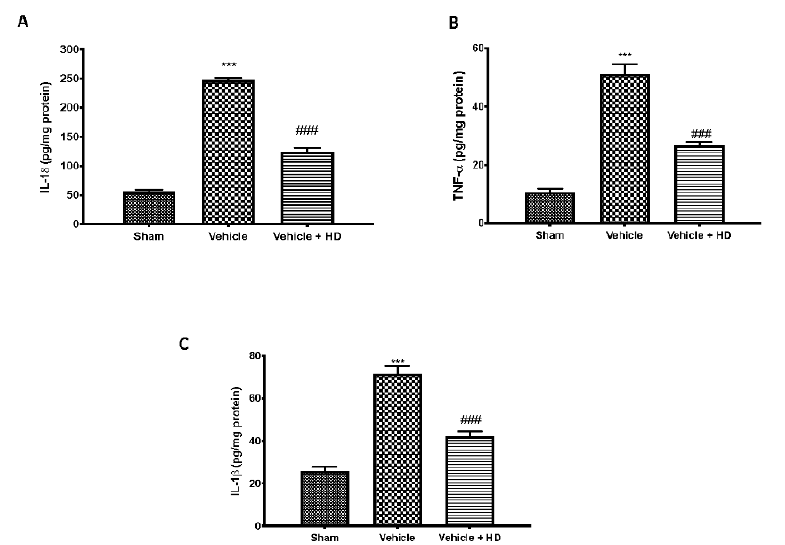
Figure 2. Effect of HD on pro-inflammatory cytokines levels: ELISA assay of IL-18 ( A ) TNF- α ( B ) and IL-1 β ( C ) *** p < 0.001 vs. sham; ### p < 0.001 vs. vehicle.